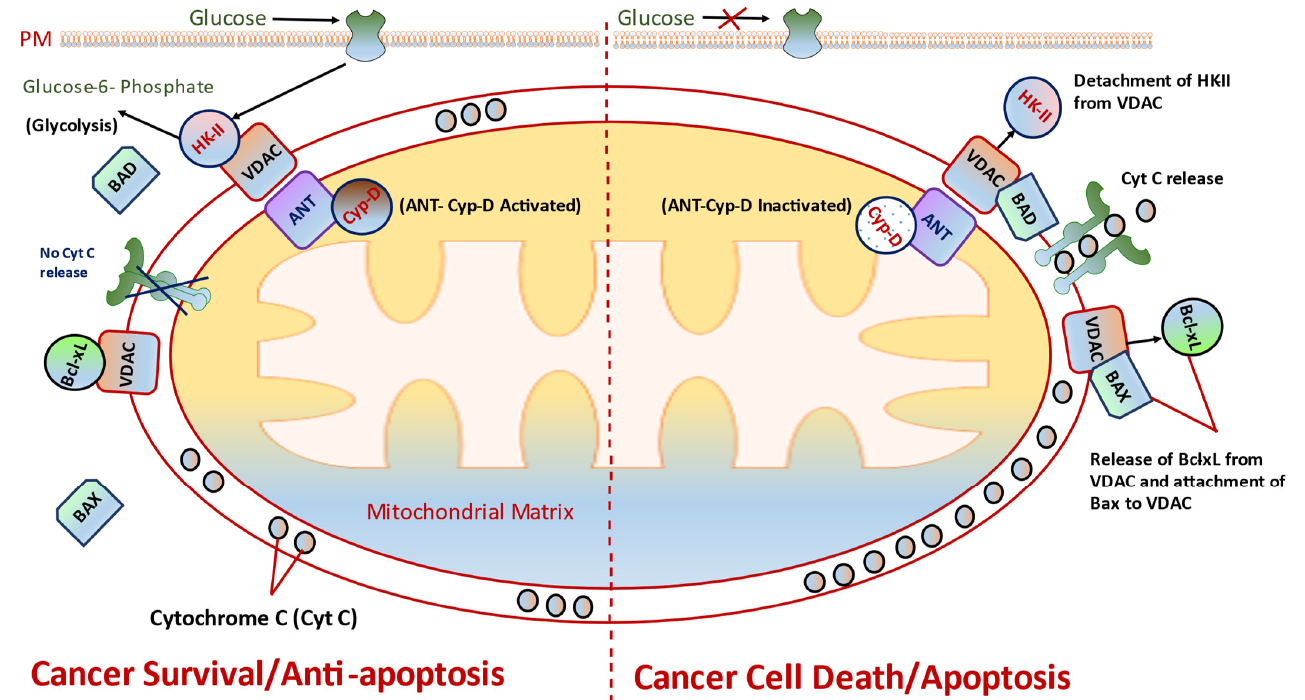
Figure 3. Mitochondrial-bound HKII is a well-considered player for providing glucose supplementation to cancer cells, thereby preventing tumor apoptosis. Targeting HKII or disrupting HKII–VDAC interaction will then initiate cell apoptosis. On left: cancer survival or antiapoptotic state persists in cancer cells within the critical conditions existing in tumor microenvironment. For instance, cytochrome c release, detachment of HKII from VDAC/ANT/CyD, and inactivation of BAX or BAD block the cell apoptotic cascade, and therefore no activation of the mPTP is allowed. On right: cancer cell death/apoptosis. HK-II is capable of detaching from VDAC, which blocks glucose supplementation and inhibits/decreases Bcl-2 proteins that in turn facilitates the switch-on of both apoptotic proteins BAX and BAD and alters both ANT and CyD, ultimately triggering mPTP opening and leading to the release of cytochrome c from the IMM to the cytosol.